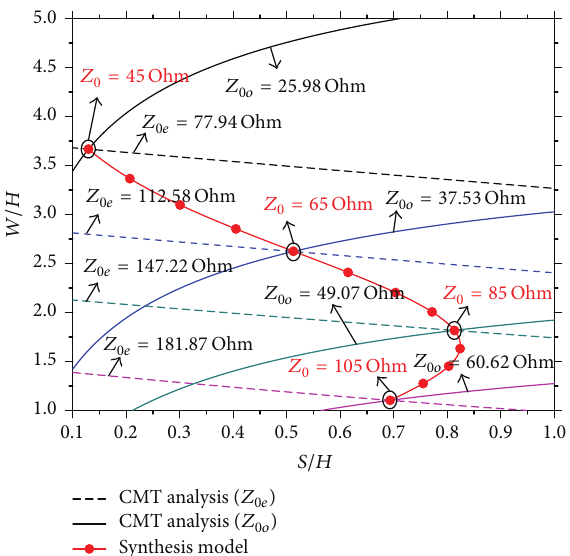
Figure 3: Comparison of results obtained from ANN-based syn- thesis model and CMT analysis contours for the PCMLFGPC with = 3.5 , 𝑊 /𝐻 = 3.5 , 𝑆 /𝐻 = 1 , and 𝐶 = 0.5 . 𝜀 𝑟 𝑓 𝑔